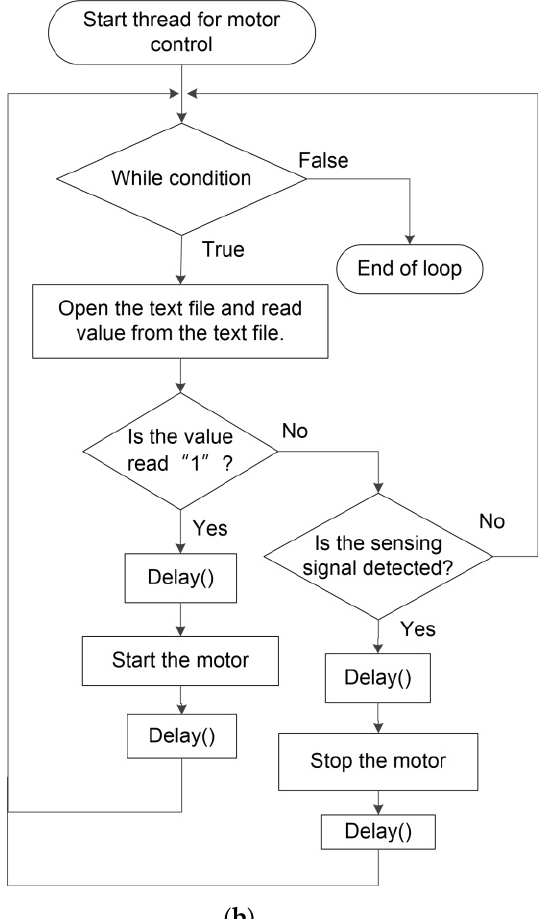
Figure 6. Software program flow for weeding system. ( a ) program flow for weed detection; ( b ) program flow for weeding operation.